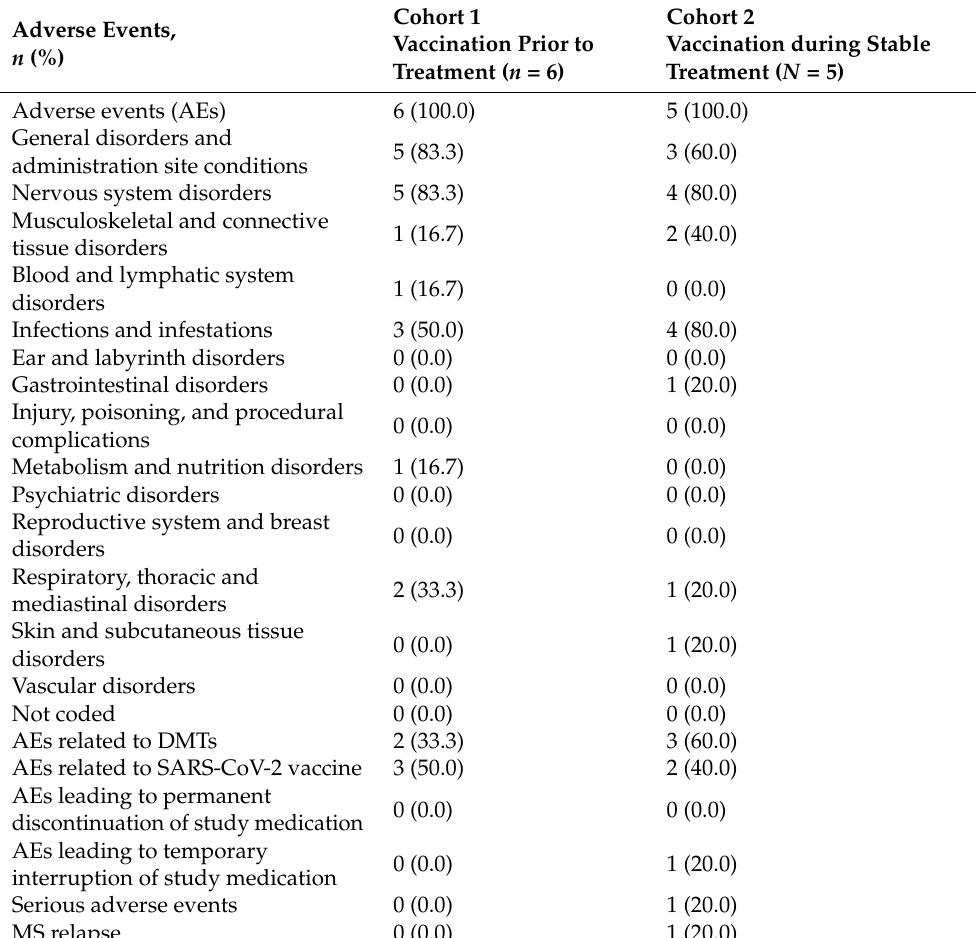
Table 3. Overview on adverse